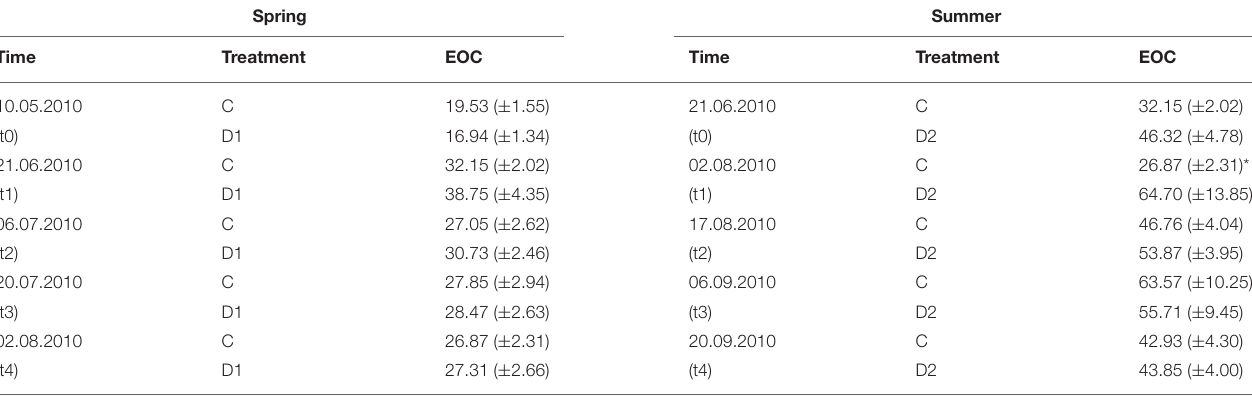
TABLE 1 | Extractable organic carbon (EOC) of grassland plots in 2010 [ µ g g − 1 dw] for different precipitation variabilities for spring drought (D1) and summer drought (D2); given are mean values and standard errors, each n = 5. Spring Summer Time